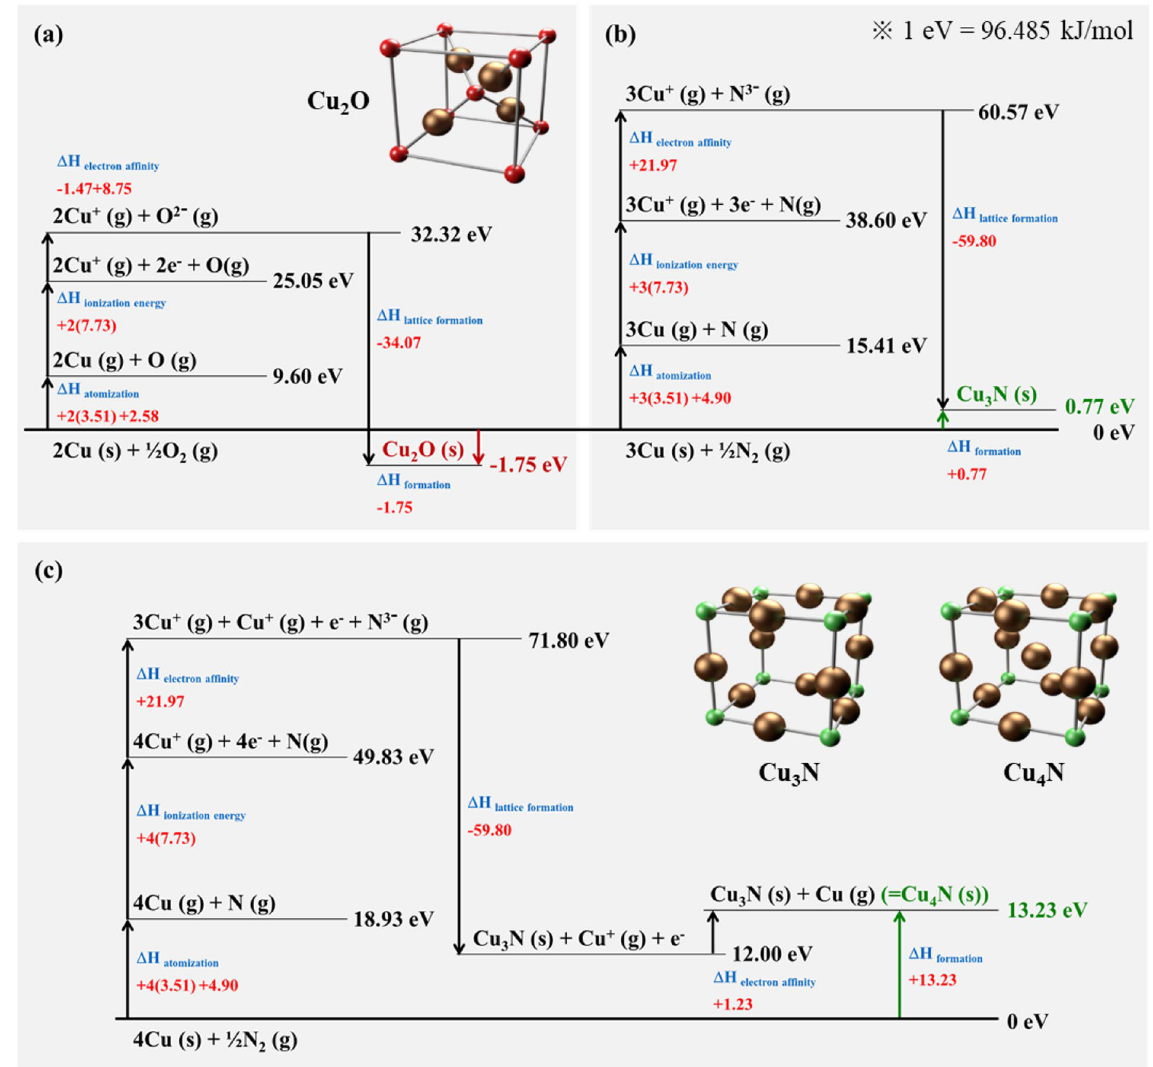
2 O, ( b ) Cu 3 N, and ( c ) Cu 4